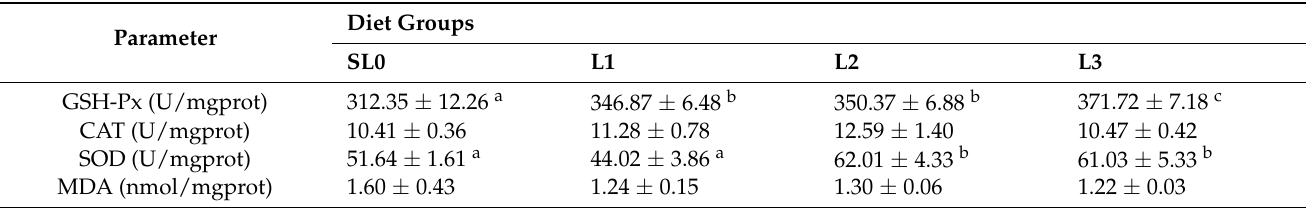
Table 5. Effect of diet supplementation with α -LA on the antioxidant capacity of the livers of juvenile hybrid groupers.